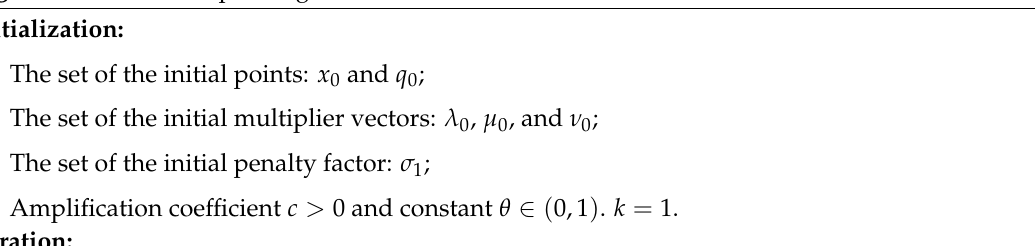
Algorithm 1 The multiplier